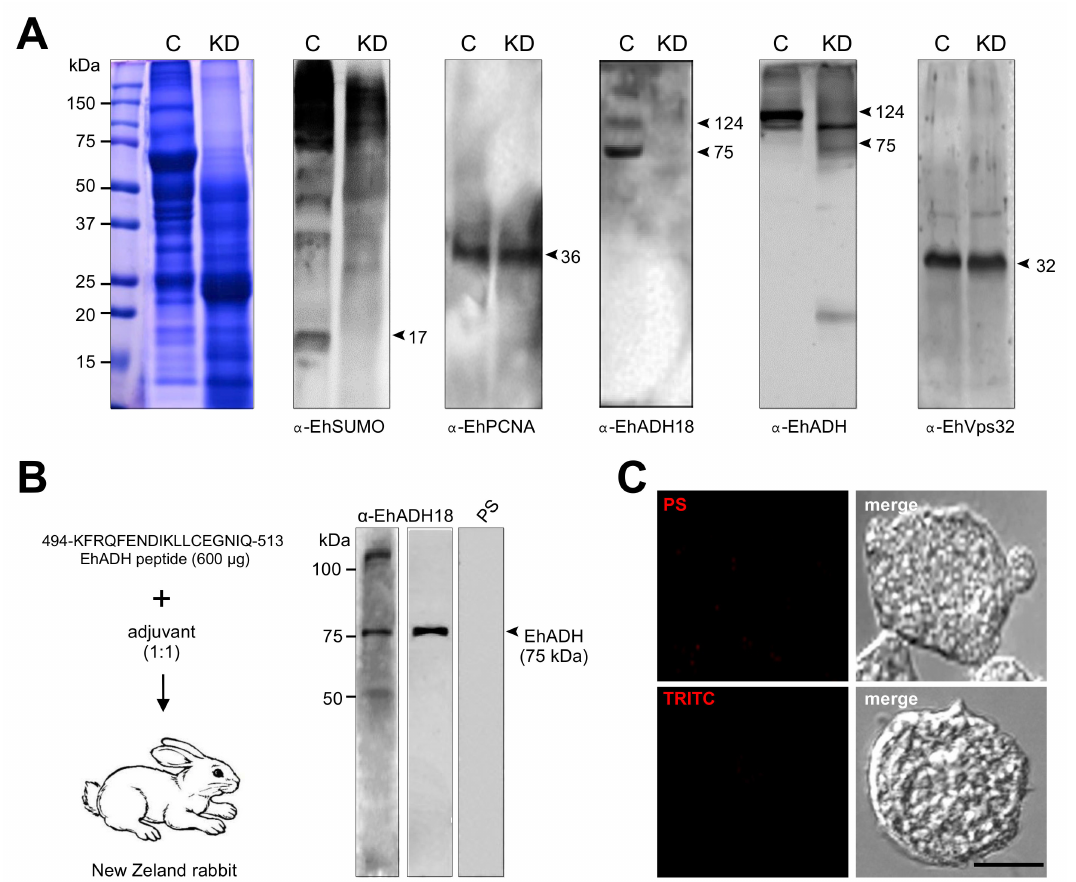
Figure 10. Effect of EhSUMO knock-down in the expression of EhADH and EhVps32 proteins. Trophozoites were silenced using the pL4440/ EhSUMO plasmid as described in materials and methods. ( A ) Coomassie staining or western blot of lysates from control ( C ) or EhSUMO-KD trophozoites (KD) in basal condition, using different antibodies: α -EhSUMO, α -EhADH18, α -EhADH, or α -EhVps32. α -EhPCNA: loading control. Numbers at left: molecular weight standards. Number at right: molecular weight in kDa of immunodetected proteins. ( B ) The α -EhADH18 antibody generated in rabbits and using an EhADH peptide of 18 residues, was tested in trophozoites lysates (lane 1) and with the recombinant protein EhADH (lane 2). As a control, the pre-immune serum (PS) was employed in trophozoites lysates (lane 3). ( C ) Confocal images of trophozoites incubated with PS or only with the secondary antibodies (scale bar = 10 µ